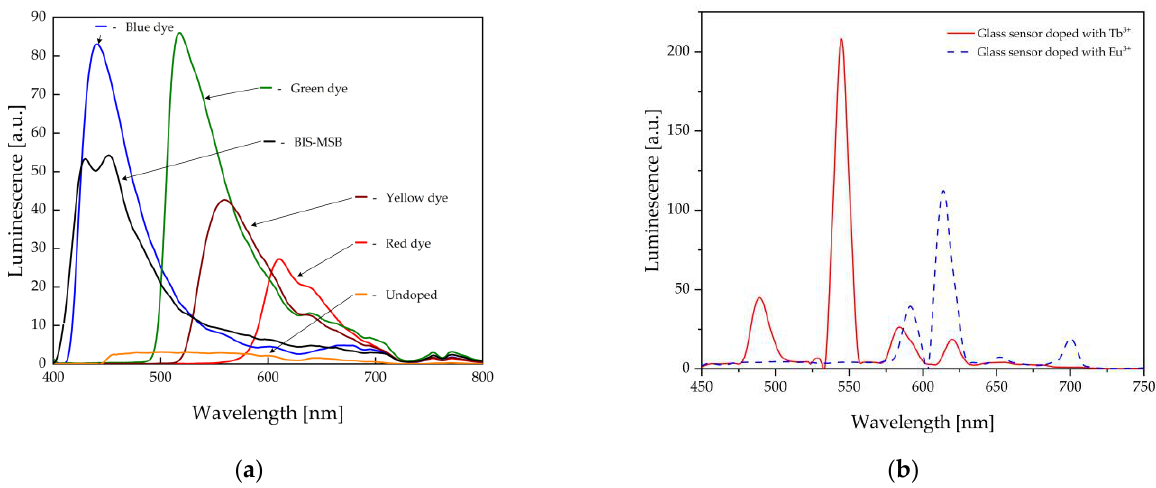
Figure 8. Luminescence spectra of ( a ) the PMMA and ( b ) the phosphate glass of the fabricated sensor heads. sensor